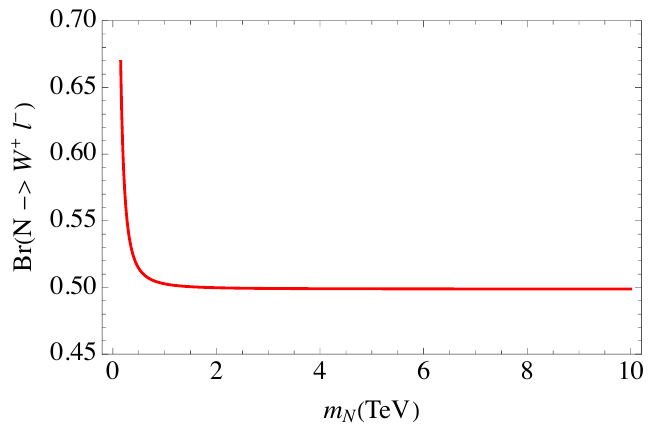
Figure 3 . The branching ratio of the Dirac HNL decay channel N ‘ −→ W + ‘ − as a function of m N . This channel allows full reconstruction of the HNL decay and reaches the equivalence limit of 50% at ∼ 1